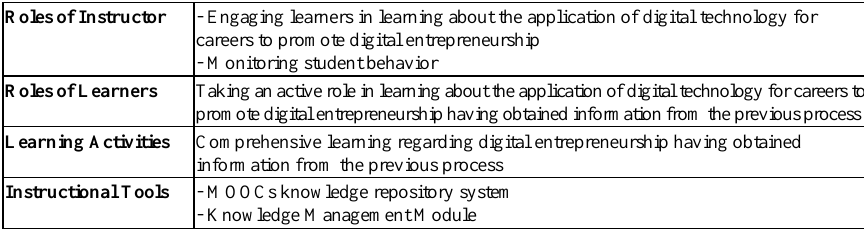
Table 4. Knowledge